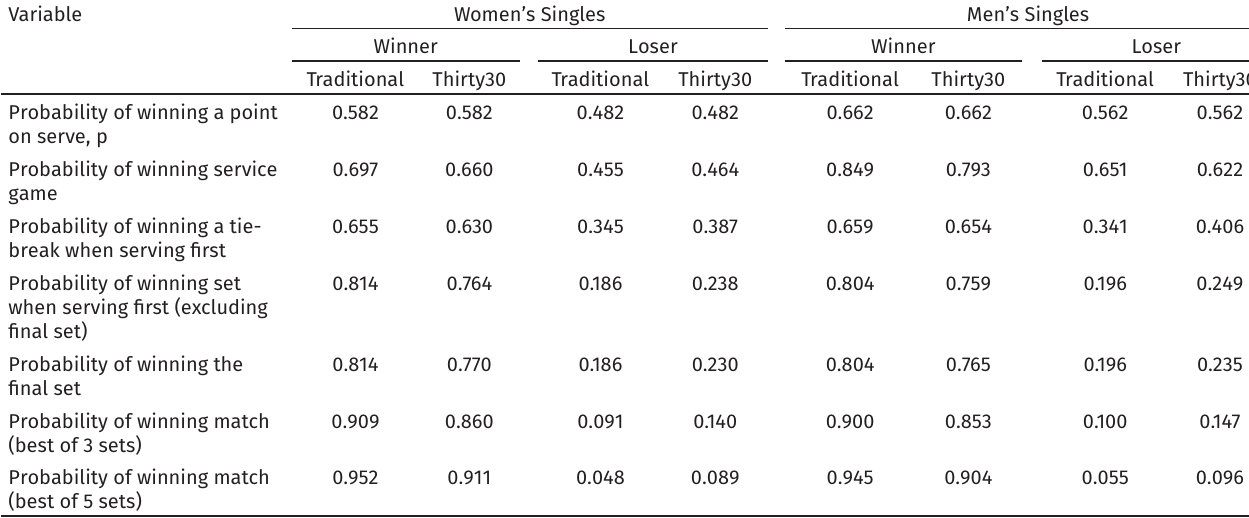
Table 1. Probabilities of players winning points, games, tie-breaks, sets and matches in typical Australian Open singles performances (probabilities are at the start of the given units of play).